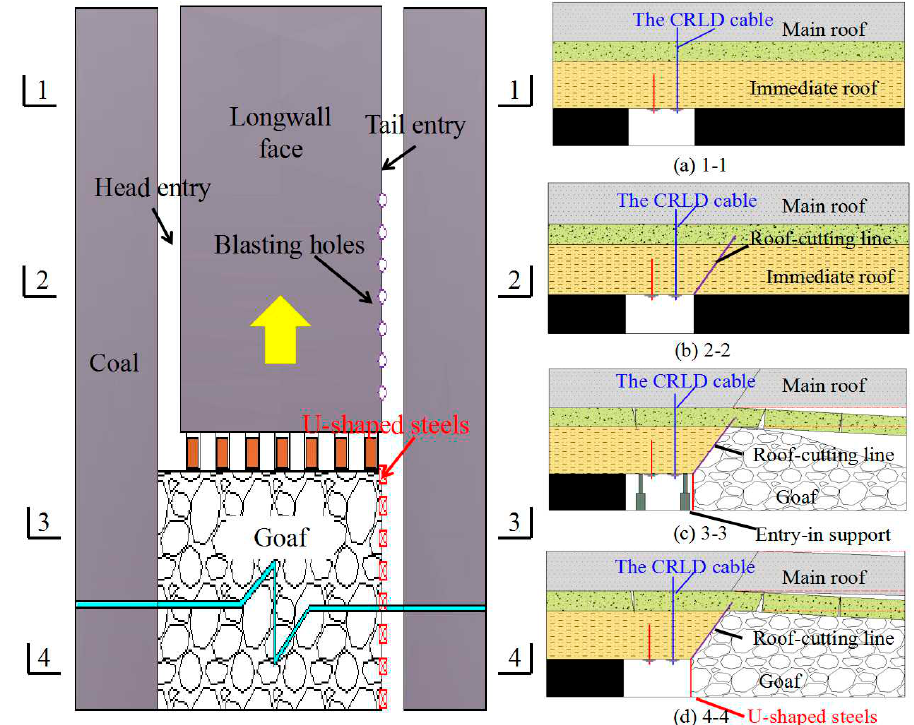
Figure 5. The implementation procedure of the fracturing roofs to maintain entry (FRME): ( a ) The procedure of strengthening the entry roof by constructing the constant resistance large deformation (CRLD) cables. ( b ) The procedure of implementing blasting holes and fracturing the retained entry roof. ( c ) The procedure of installing U-shaped steels and entry-in supports when the coal is mined. ( d ) The procedure of withdrawing the entry-in supports when the retained entry keeps stable.